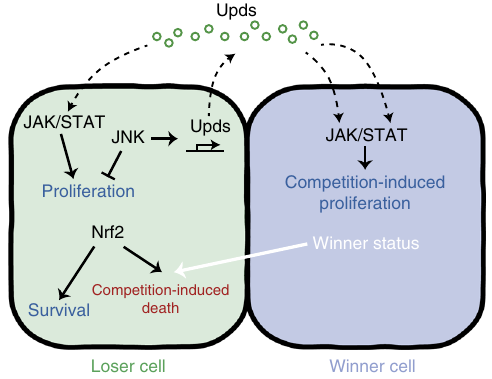
Fig. 7 A proposed model for the contribution of JNK, JAK/STAT and Nrf2 pathways to cell competition. JNK signalling activation restricts the growth of loser cells. JAK/STAT signalling, activated by the Unpaired ligands secreted by the loser cells, plays a dual role: it promotes the proliferation of prospective loser tissue, as well as the overproliferation of winner cells during cell competition. Nrf2 pathway activation in losers also plays a dual role: it promotes prospective loser cell survival; however it also primes loser cells for their elimination by WT neighbours during cell